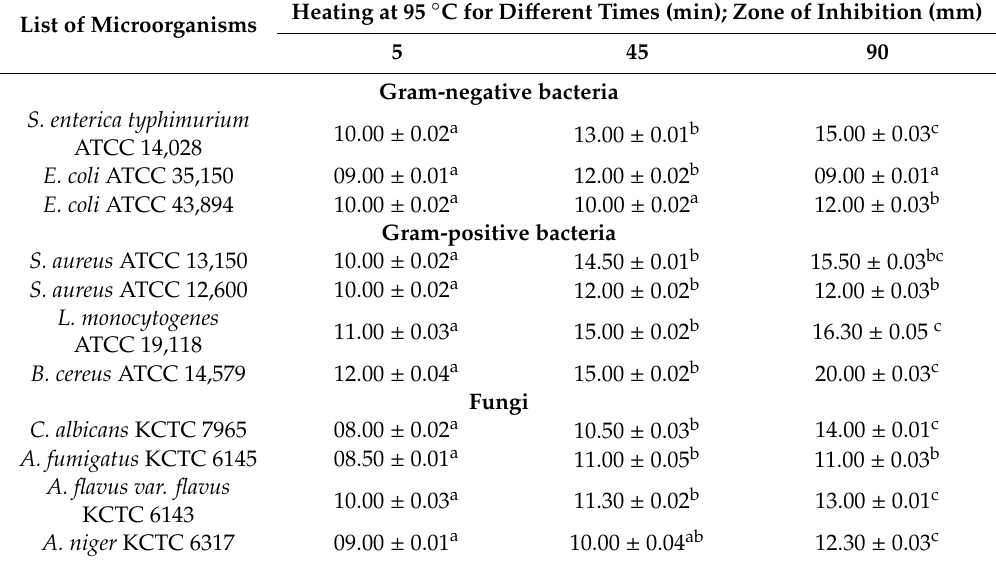
Table 2. Thermostability of the chloroform extract of